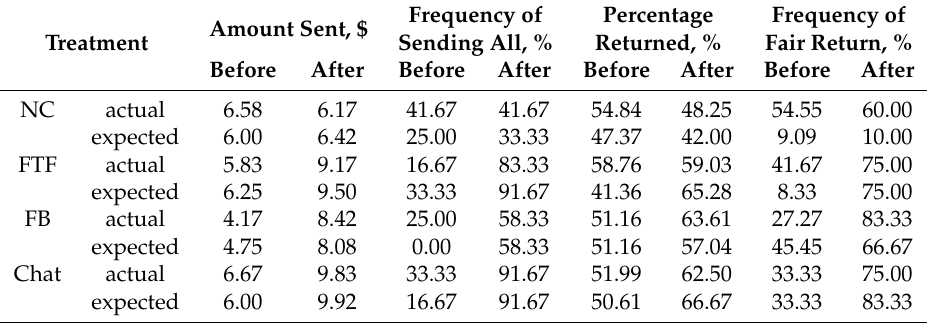
Table 2. Amounts sent and returned before and after